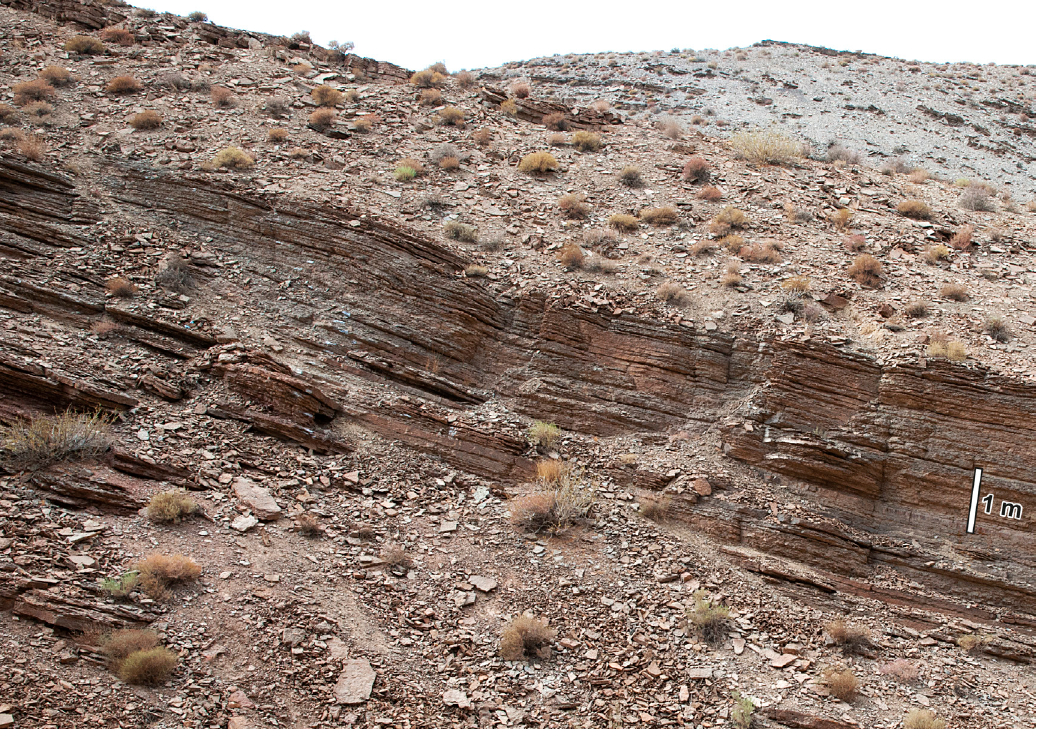
Fig. 4. The upper portion of the Hambast Formation ( Paratirolites Limestone equivalent) in Baghuk Mountain 1